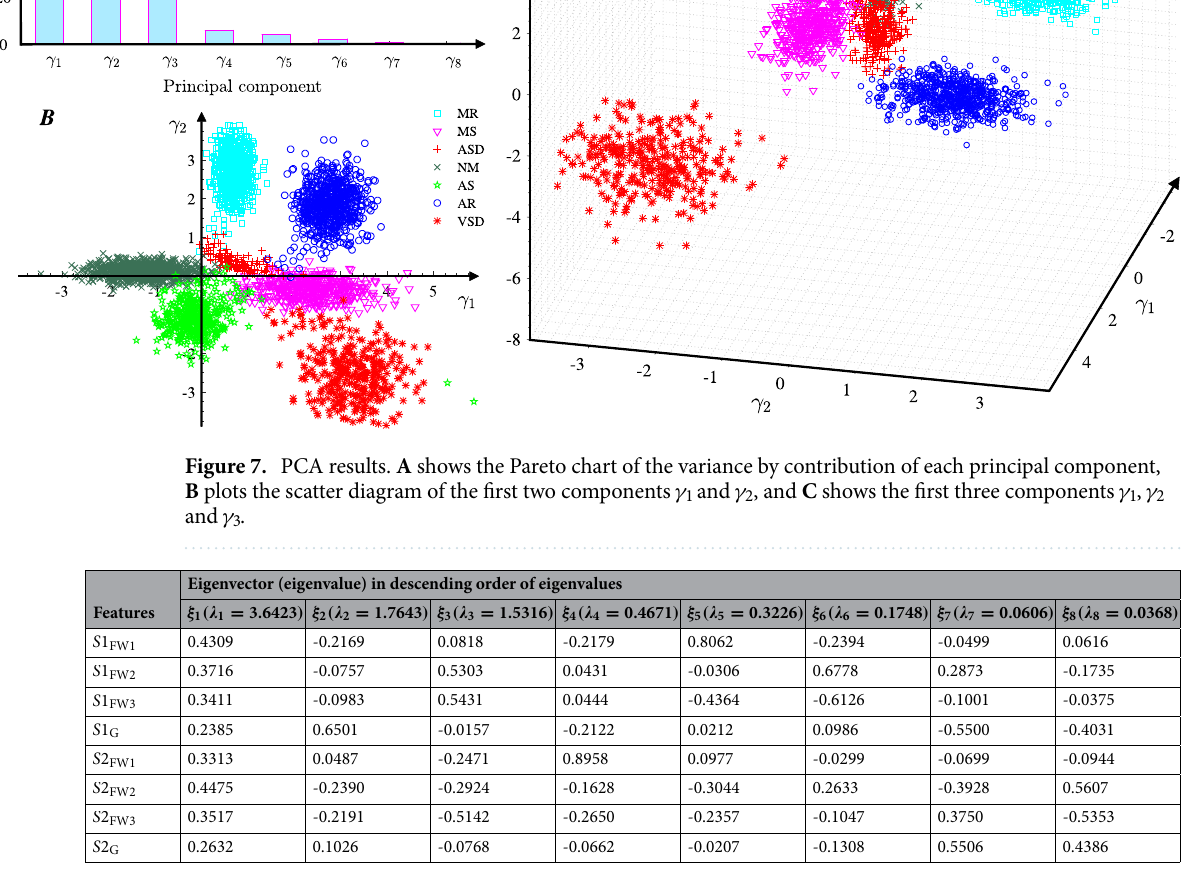
Table 3. Eigenvector ξ i and eigenvalue (cid:31) i ( i = 1, . . . , 8 ) for (cid:31) in descending order of eigenvalues.